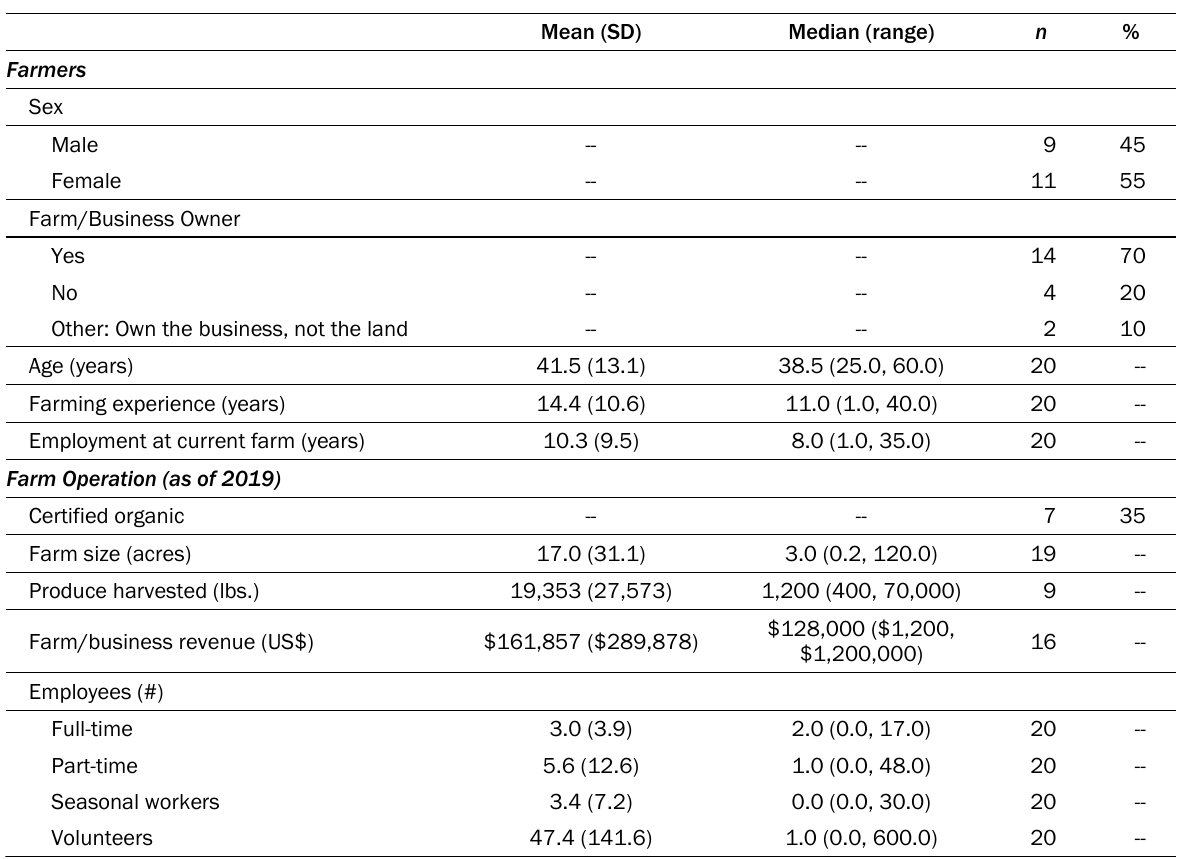
Table 1. Characteristics of Farmers and Farms ( N